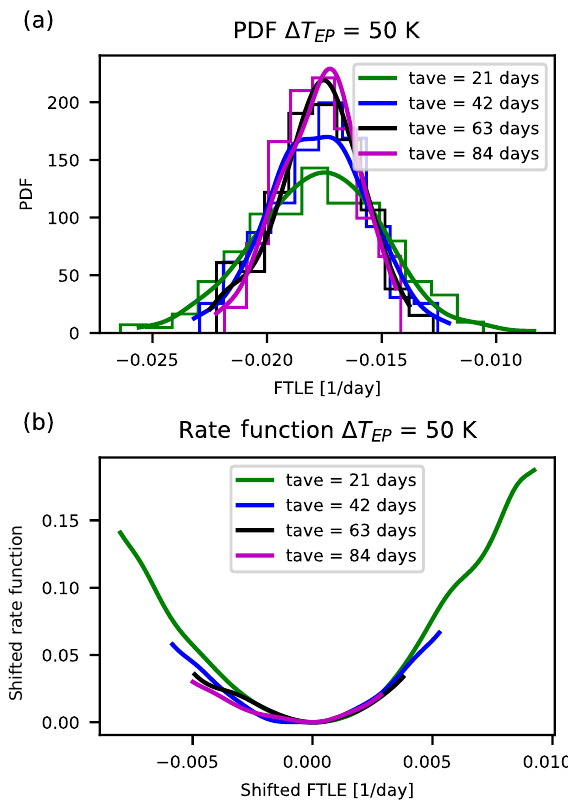
Figure 5. Distributions and rate functions of λ 150 , a strongly de- caying direction in PUMA, for (cid:49)T EP = 60K. Panels as in Fig.